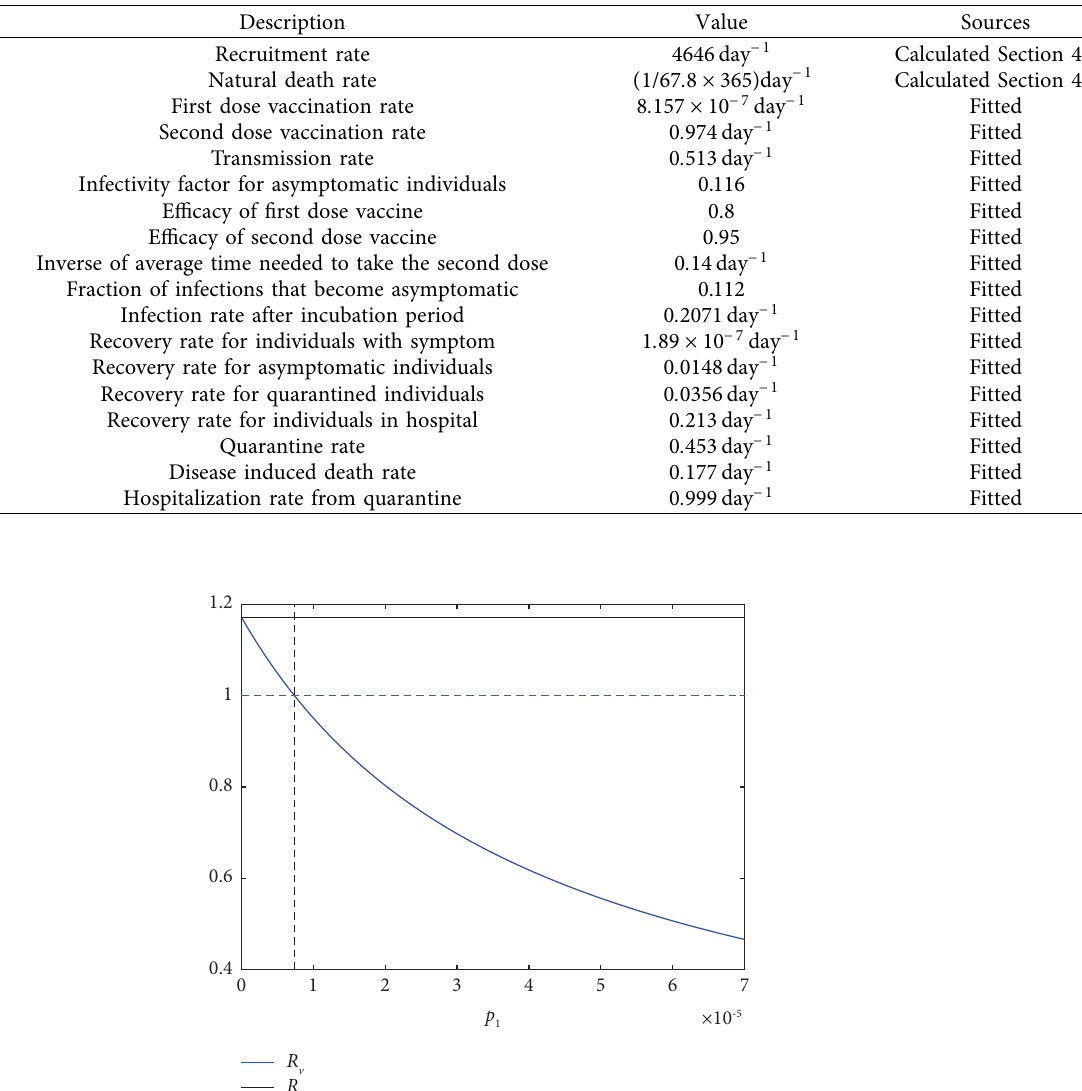
. Te red broken 0